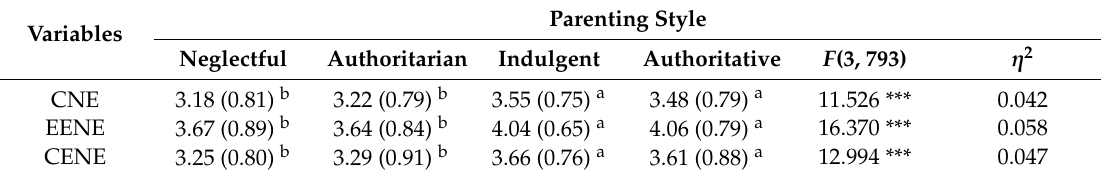
Table 3. Means (standard deviations) of parenting style, as well asmain univariate F values for connectedness to the natural environment, emotional empathy to natural environment, and cognitive empathy for natural environment.